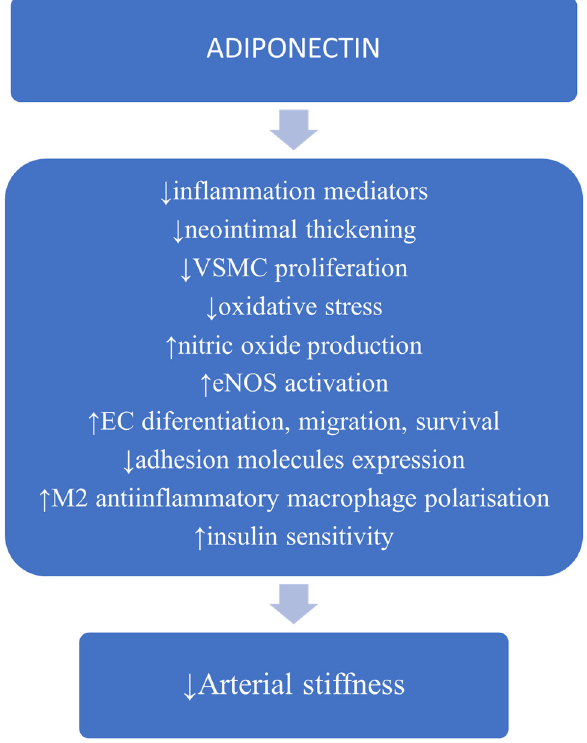
Figure 2. Possible mechanisms involved in adiponectin protection against the development of arterial stiffness (information based on cited articles). Abbreviations: VSMC, vascular smooth muscle cell; eNOS, endothelial nitric oxide synthase; EC, endothelial cell.